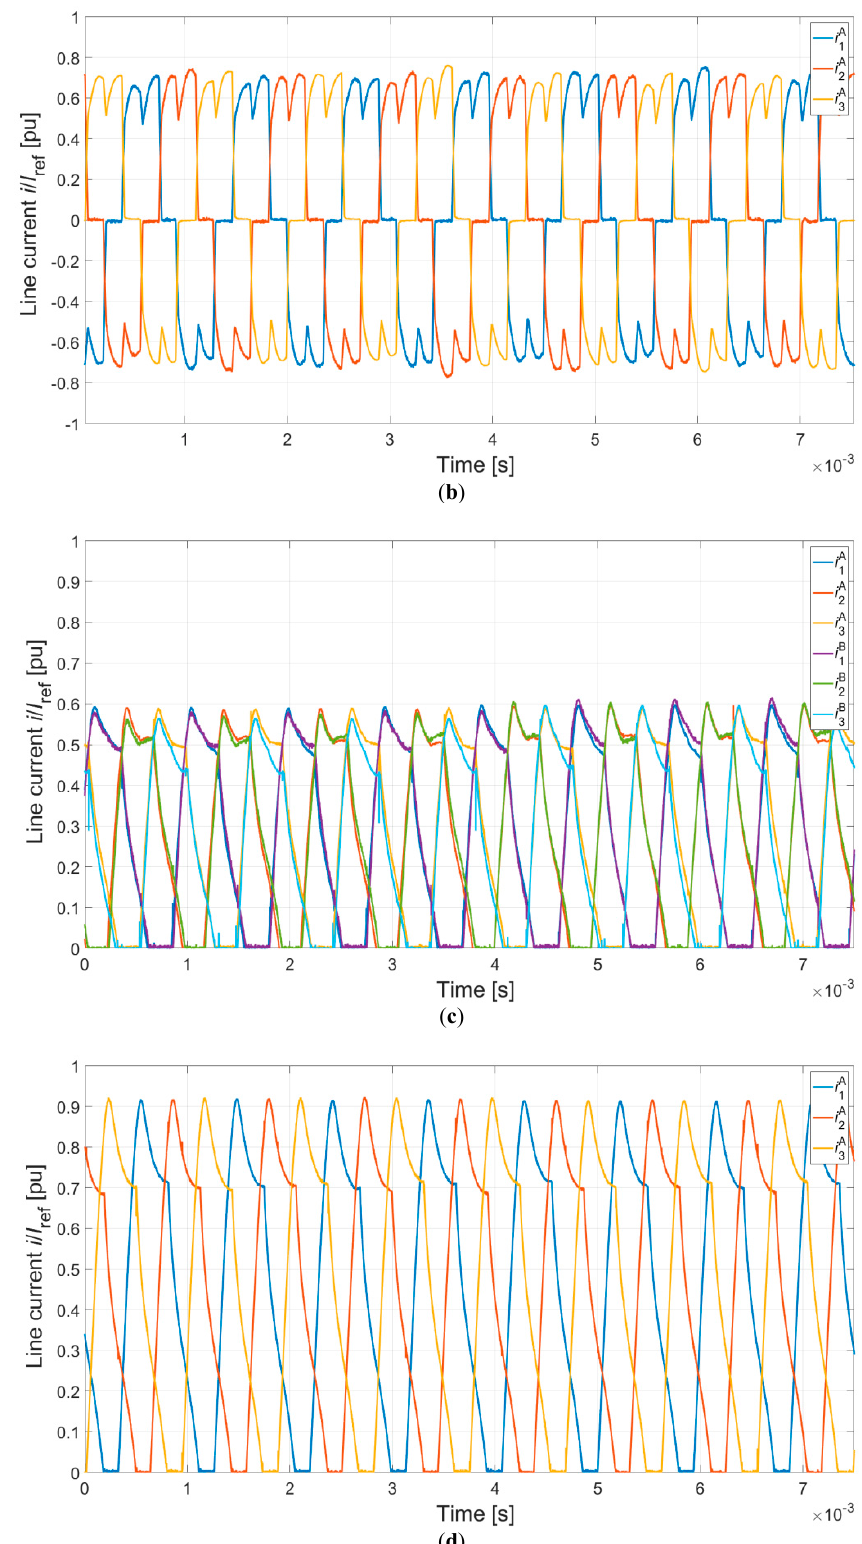
Figure 8. Relative line currents in DCO and SCO modes for the DCBLDCM and the DCSRM in a high-speed laboratory test. ( a ) Line currents for the DCBLDCM in DCO mode. ( b ) Line currents for the DCBLDCM in SCO mode. ( c ) Line currents for the DCSRM in DCO mode. ( d ) Line currents for the DCSRM in SCO mode.